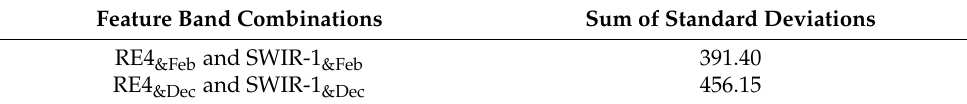
Table 1. Sum of standard deviations of feature band combinations for pine-oak mixed